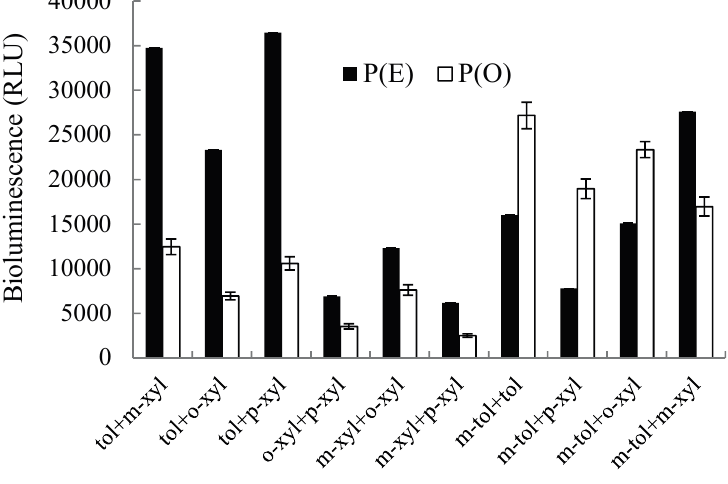
Figure 3. Comparison between observed P(O) and expected P(E) bioluminescence intensities in the presence of binary inducer mixtures. Each bar presents average of P(O) or P(E) bioluminescence intensities of four